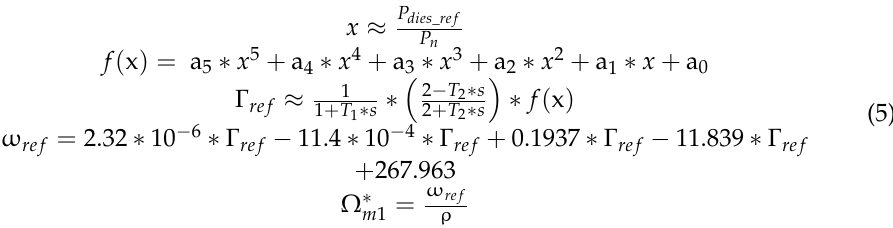
Table 1. UTILIZED PARAMETERS IN MICRO-GRID SYSTEM SIMULATIONS.